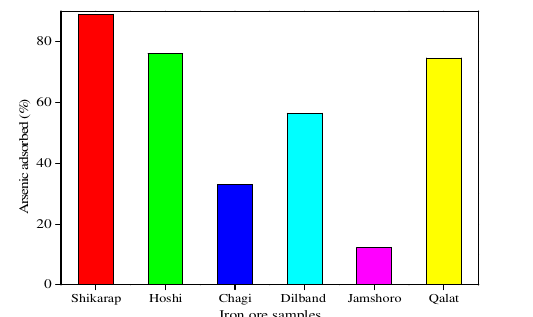
Iron ore samples Fig. 3: Adsorption Behavior of Iron Ores (Sorbent Dose 0.5g